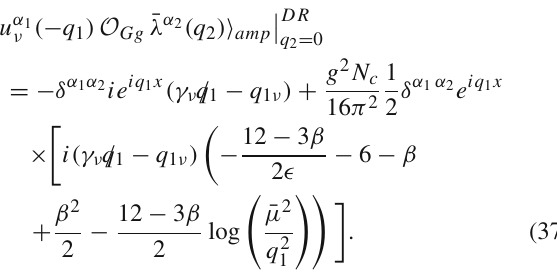
of the operator. The “double dashed” line is the ghost field. Diagrams 1 and 2 do not appear in dimensional regularization; they do however show up in the lattice